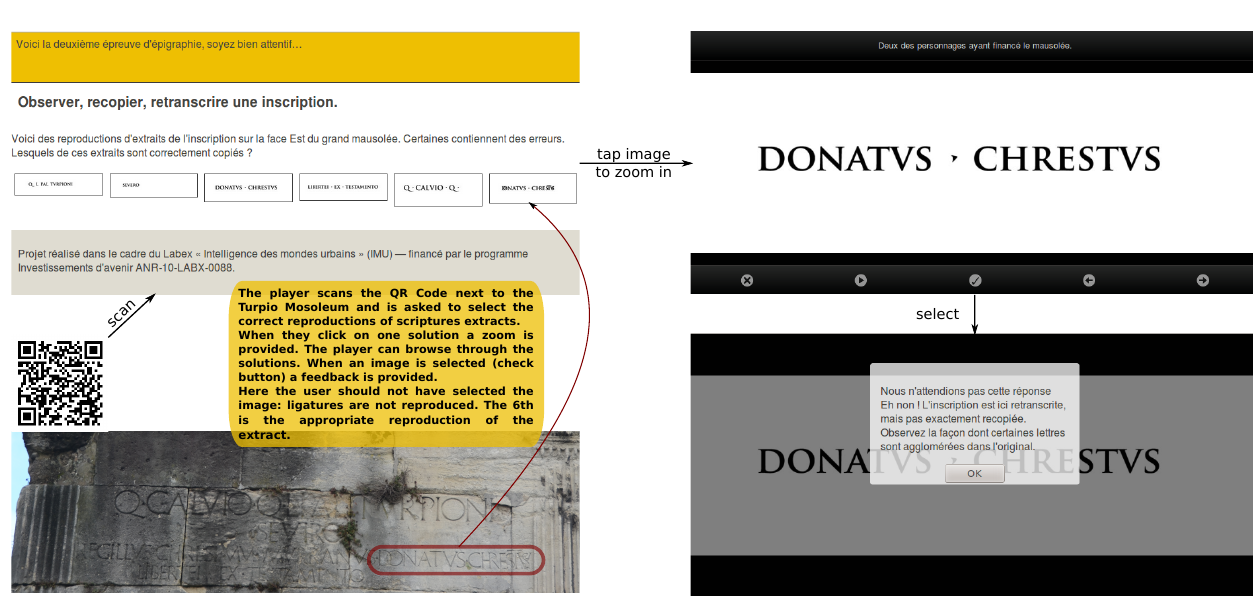
Figure 2. Screen capture and functionning of PhotoSwipe.Quizz